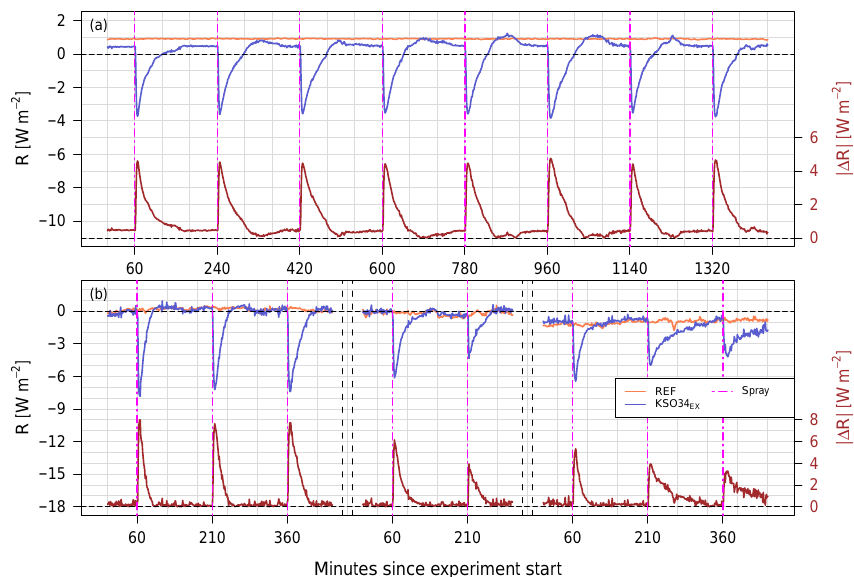
Figure 4. Time series of the radiation ( R ) measured by the reference (REF, coral, Eigenbrodt HV-system) and experimental pyranometer (KSO34 EX , blue, KSO HV-system) and the absolute difference ( | (cid:49)R | ) between REF and KSO34 EX during (a) laboratory conditions and (b) ambient environmental conditions. All field measurements were performed during nighttime. The measurement series is continuous in (a) , while the start point of subpanels (separated by vertical double dashed lines) in (b) is always 18:30UTC. Note that the scales of the y axes differ between